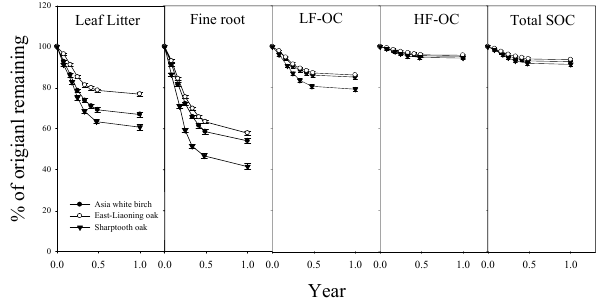
2 Fig. 4. Leaf litter mass, fine root mass, light-fraction organic carbon 3 (LF-OC), heavy-fraction organic carbon (HF-OC) and total soil or- ganic carbon (SOC) remaining (% of initial) in Asia white birch and East-Liaoning oak forests of warm temperate zone and Sharptooth oak forest of sub-topical zone during the 1-year period. Vertical bars indicate standard errors of means ( n